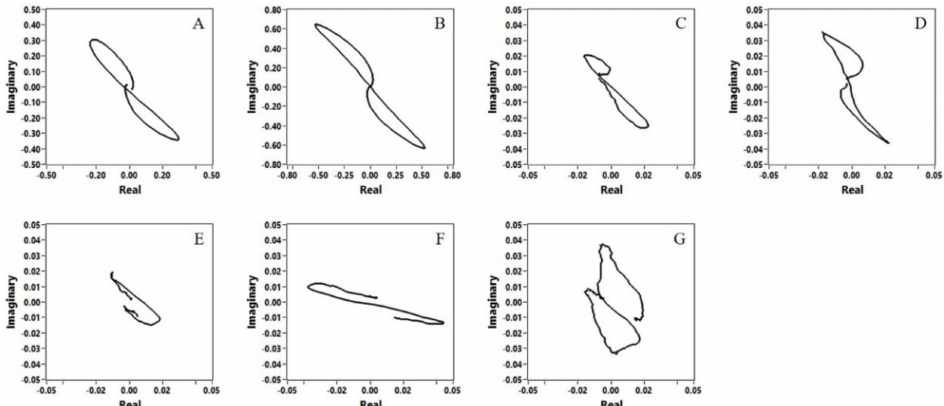
Figure 5. Lissajous curves from the front bobbin coils for the specimen with di ff erent type flaws (50 kHz AC).